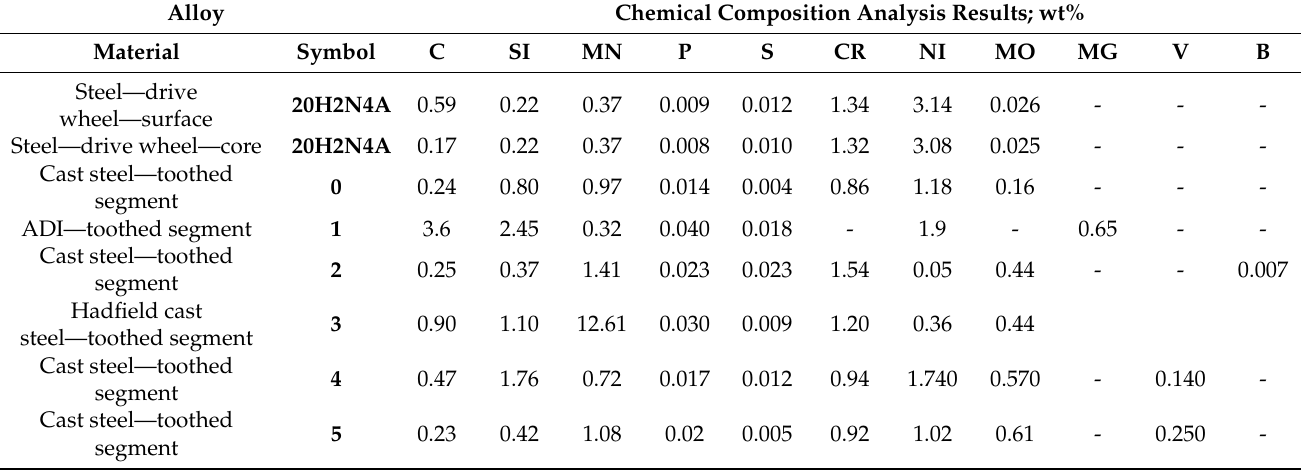
Table 1. Chemical compositions of the tested alloys.